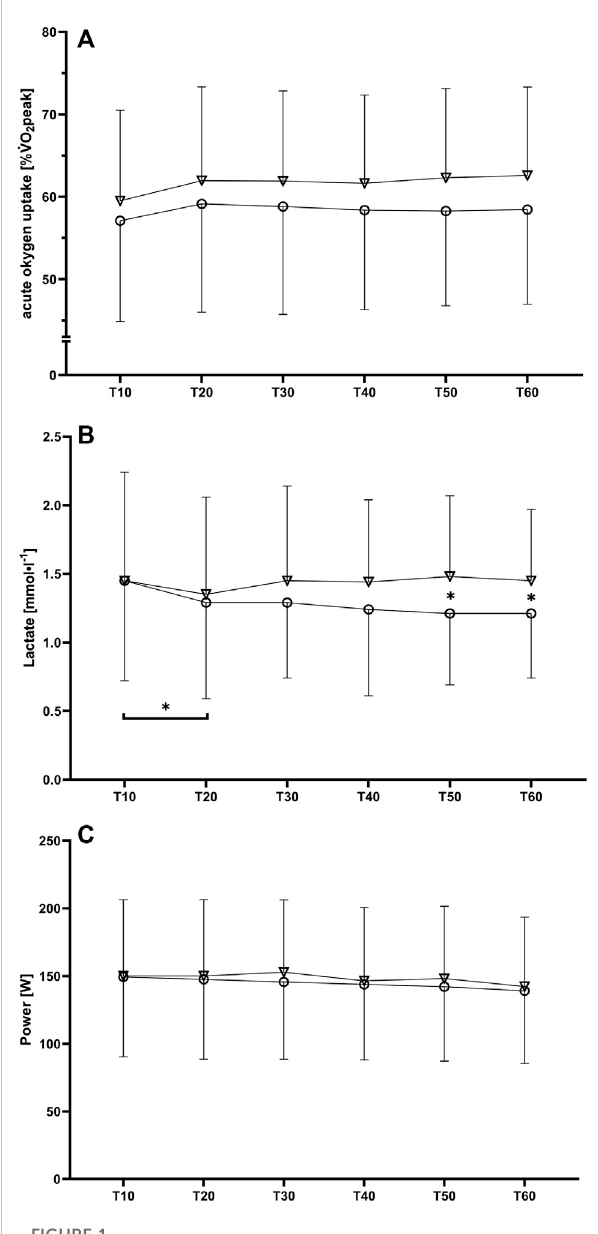
FIGURE 1 Mean values and standard deviations for (A) oxygen uptake related to VO 2 peak, (B) blood lactate concentration and (C) power output during the six 10-min intervals (T10 to T60) for the nasal-only (circles) and oro-nasal (triangles) training condition. * p <